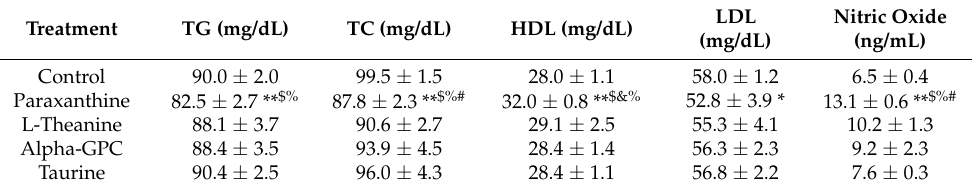
Table 5. Serum levels of triglycerides (TG), total cholesterol (TC), high-density lipoprotein cholesterol (HDL), low-density lipoprotein cholesterol (LDL), and nitric oxide levels after 28 days of treatment.